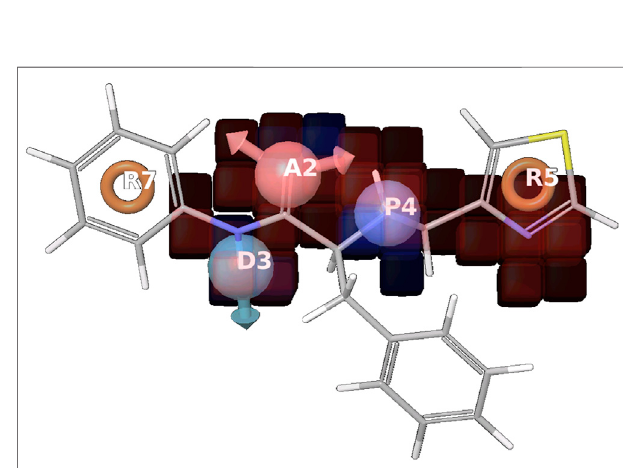
FIGURE 5 | Positive coef fi cient represented by dark blue color and Negative coef fi cient represented by the red color, Hydrogen bond donor (D), Hydrophobic/nonpolar (H), Electron-withdrawing (W) shown in the red cube, where R5 has a common pharmacophoric feature, responsible for the activity. A2 are in the negative coef fi cient and other R7, D3P4, and R5 are in the positive coef fi cient shown in the supplementary information ( Supplementary Figure S2